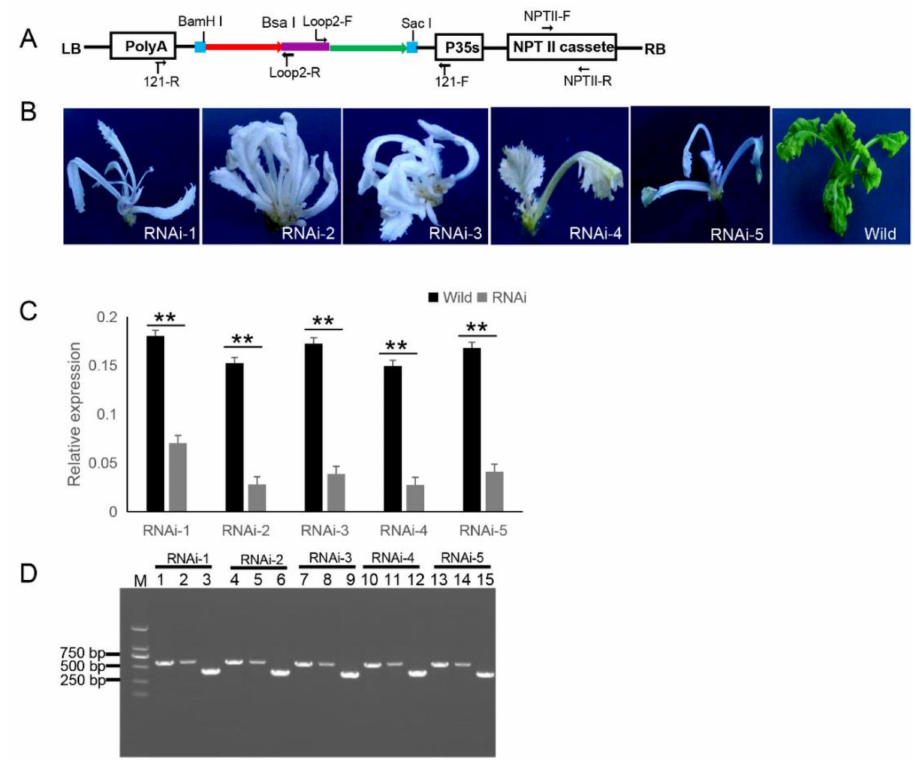
Figure 3. 121-PDS-ihpRNA-mediated silencing of the PDS gene. ( A ) Map of the binary vector 121-PDS-ihpRNA. NPTII-F and NPTII-R primers were used in the identification of positive transgenic plants, the primer pairs loop2-F / 121-F and loop2-R / 121-R were utilized to rapidly screen target genes. Blue line is the adaptor1 sequence. Purple line is the adaptor2 sequence. Red line with the arrow is the sense strand of dsDNA. Green line with the arrow is the anti-sense strand of dsDNA. ( B ) Interfering phenotypes of 5 PDS-ihpRNA transgenic plants. RNAi-1, RNAi-2, RNAi-3, RNAi-4, and RNAi-5 were PDS-ihpRNA transgenic plants. Wild was the transgenic negative plant. ( C ) qRT-PCR analysis of the PDS target gene mRNA level in the five hpRNA lines shown in ( B ) using the primer pair PDS-F2 / PDS-R2. Data shown as mean ± s.d.,**, p < 0.05.. ( D ) Integration into the Brassica napus